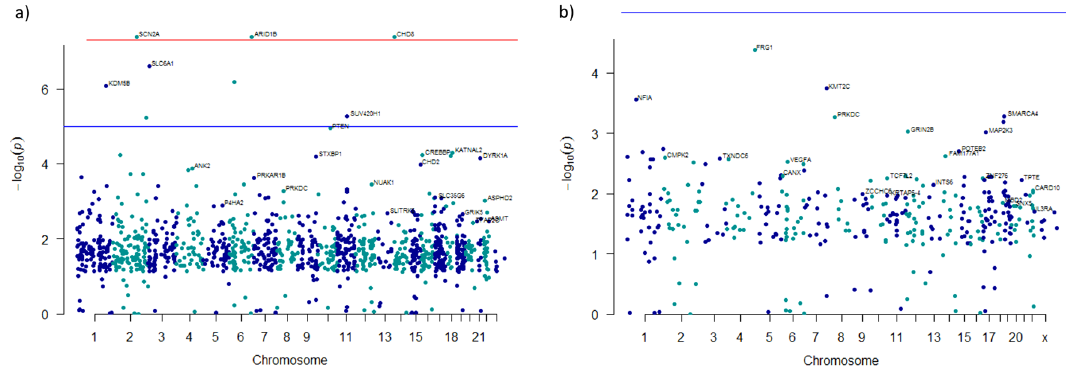
Figure 1. Manhattan plots depicting the ASD risk genes prioritized by TADA-Denovo (chromosome and log10 p value for each gene are represented in axis x and y). ( a ) p values were obtained from analysis of germinal mutations in the combined cohort using TADA-Denovo. Red line represents the p value < 1 × 10 –8 and blue line p value < 1 × 10 −5 . ( b ) p values were obtained from analysis of PZMs in the combined cohort using TADA-Denovo. Blue line represents p value < 1 × 10 −5 .